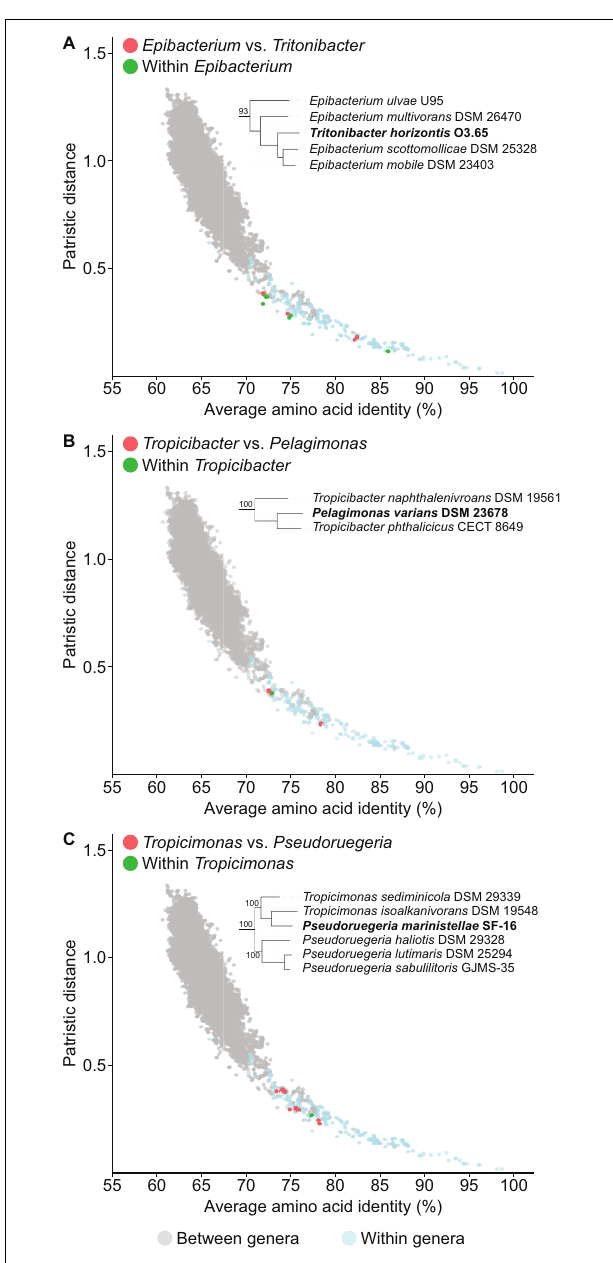
FIGURE 4 | Dot plot for patristic distance (PD) against average amino acid identity (AAI) highlighting the comparisons of representative paraphyletic genera (A) Epibacterium , (B) Tropicibacter , (C) Tropicimonas , and closely related organisms. PD and AAI comparisons for between (orange) or within (green) genera of interest are shown. PD and AAI comparisons for all between (gray) or within (blue) recognized monophyletic genera are included as reference. The corresponding phylogenetic trees are subsets of the core-genome tree ( Figure 2 ). Names in bold are organisms causing paraphyly of genera of